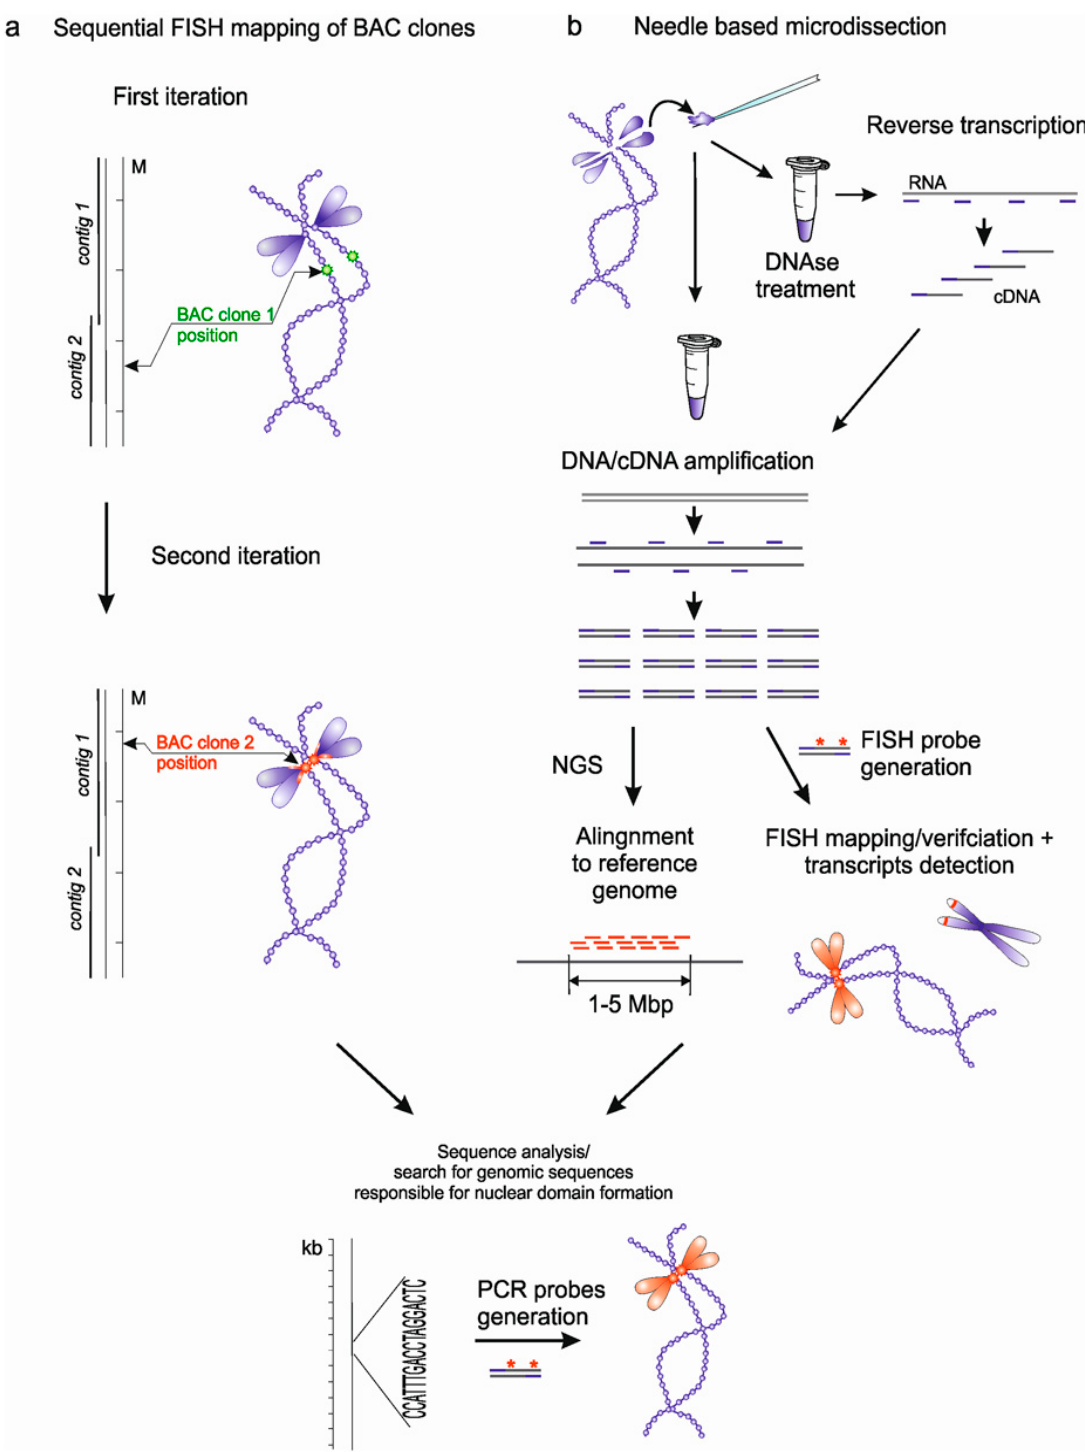
Figure 2. Scheme represents the two approaches developed for identification of the genomic loci and scaffold RNAs responsible for nuclear domain formation. ( a ) Sequential FISH-mapping of BAC clones containing genomic DNA fragments on lampbrush chromosomes to narrow down the genomic region of nuclear domain formation followed by bioinformatics analysis and scaffold RNAs identification. ( b ) Mechanical microdissection of chromomeres at the base of the nuclear domain on lampbrush chromosomes followed by generation of FISH-probes, high throughput sequencing and genome mapping of dissected DNA fragments.